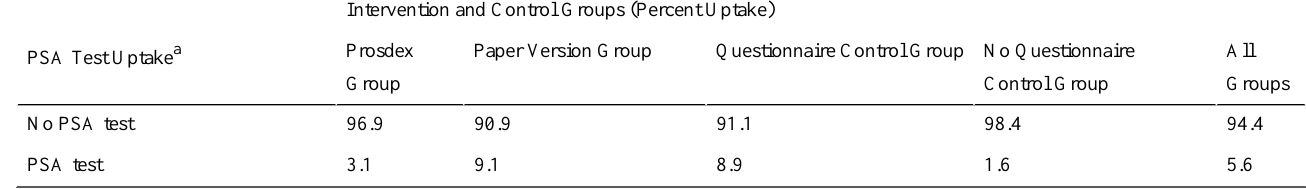
Table 4. Percent PSA test uptake by group